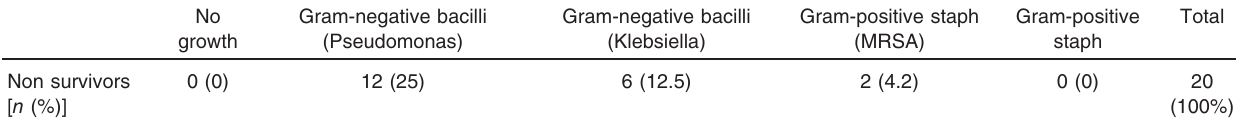
Table 13 Number of nonsurvivors with ventilator-associated pneumonia in relation to the organism causing ventilator-associated pneumonia No growth